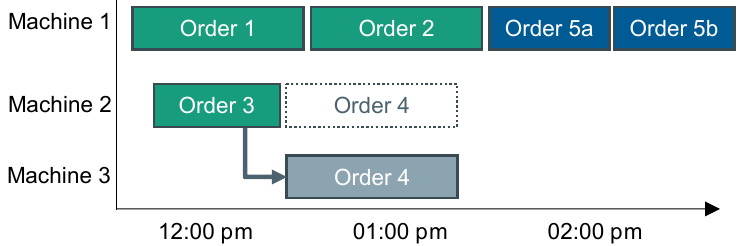
Figure 1. Integration of a risk treatment path into a production plan [6].